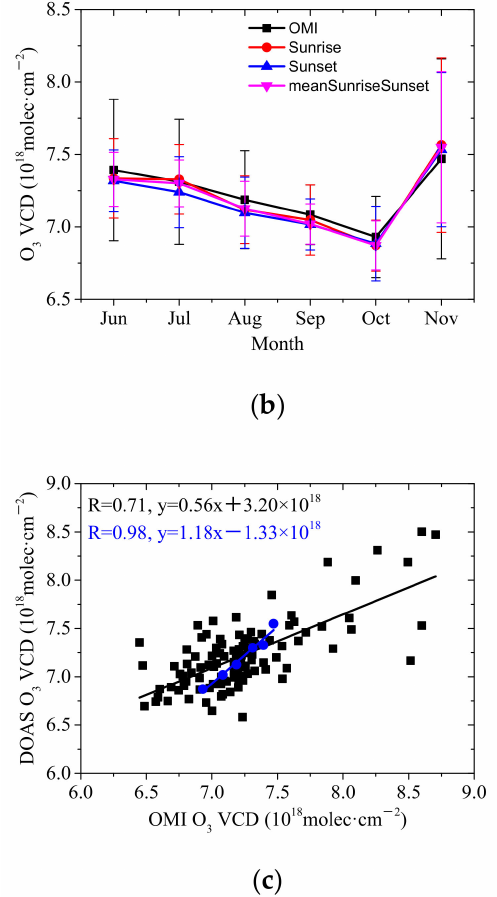
Figure 9. Temporal variation of the O 3 VCDs as well as their correlation between ground-based zenith DOAS and OMI satellite observations. ( a ) Time series of the daily O 3 VCDs; the ratios of the O 3 VCDs at sunset to those at sunrise are shown by the grey curve with stars. ( b ) The monthly variation of the O 3 VCDs; the error bars represent the standard deviations of the monthly mean O 3 VCDs. ( c ) Correlation of the daily (black squares) and monthly (blue dots) averaged O 3 VCDs of the DOAS measurement at sunrise and sunset and the OMI satellite product (OMDOAO3e); the black and blue lines indicate the linear fit between both data sets. The black curve with squares denotes the OMI satellite product (OMDOAO3e). The red, blue, and pink curves with symbols denote the O 3 VCDs measured by the ground-based DOAS at sunrise and sunset as well as the average of sunrise and sunset, respectively. R and the formula in the figure indicate the correlation coefficient and the equation of the linear regression,